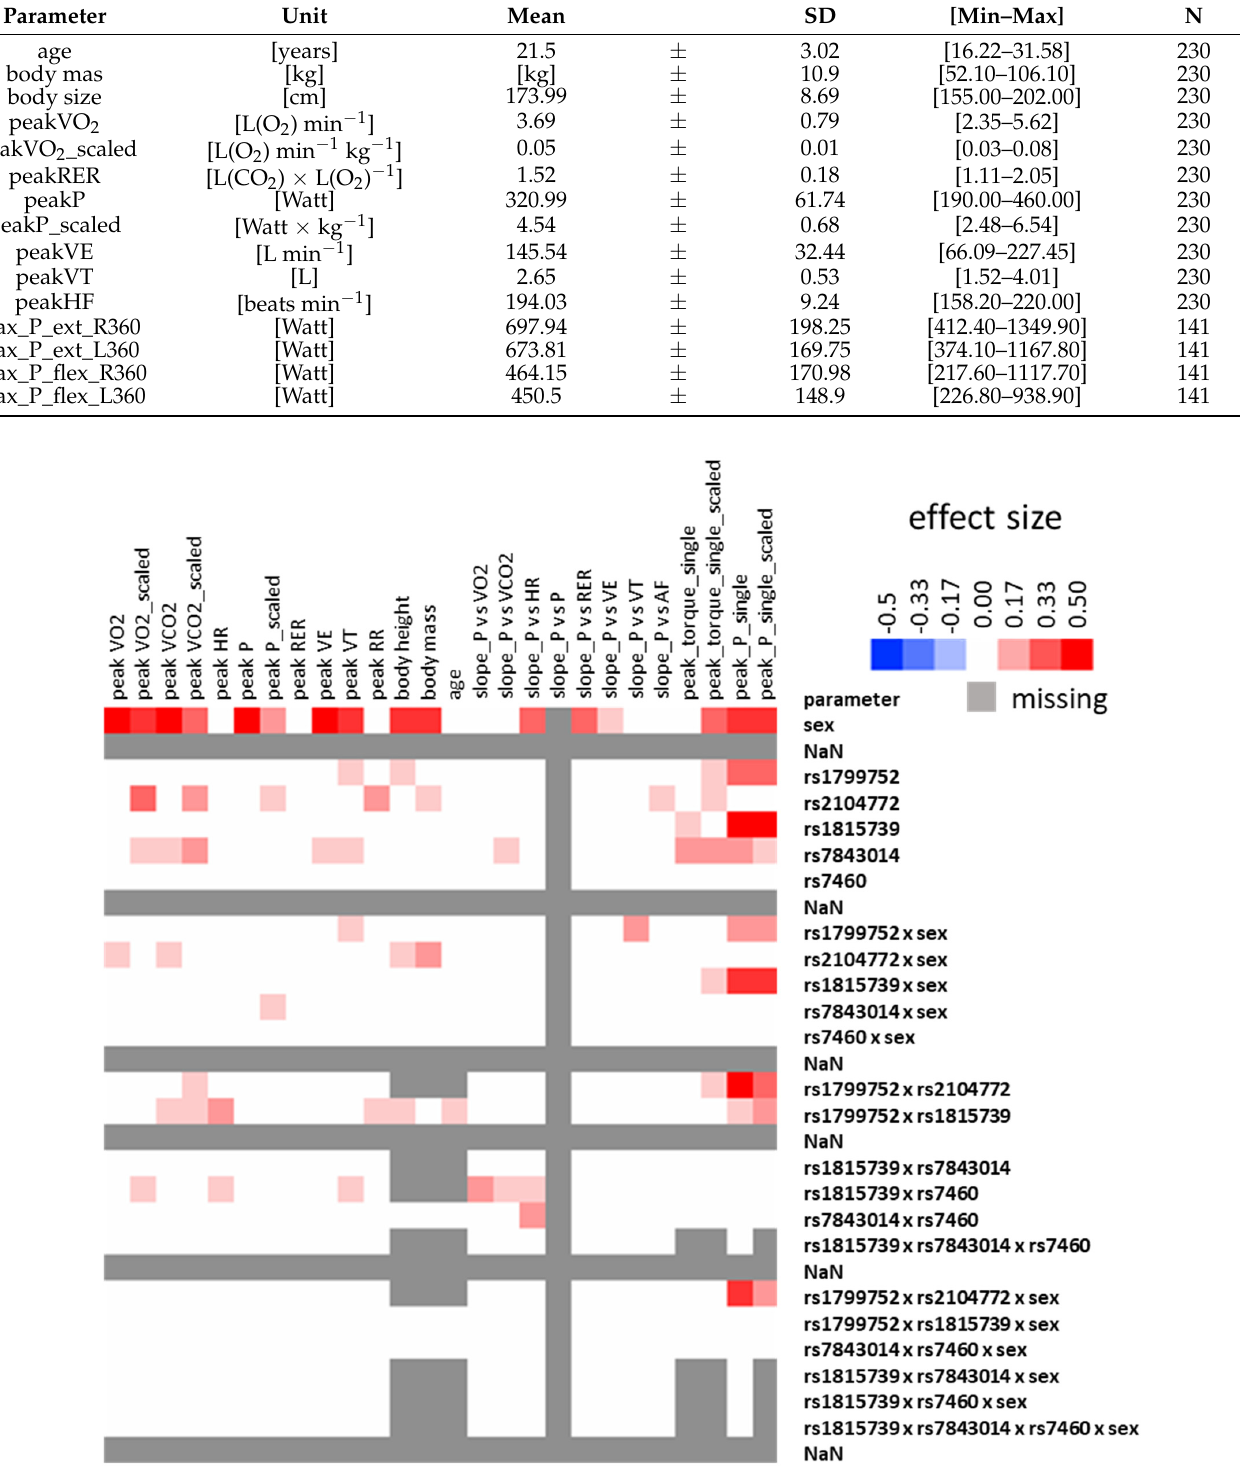
Figure 2. Heatmap of effect sizes. Coloured graph visualizing the calculated effect sizes for cardiorespiratory parameters during the CPX testing and performance values during the dynamometer test as calculated with ANOVAs for the factors genotype × sex × discipline. Effect sizes above 0.10 are coloured in red, with those below appearing in white, or if calculation was not possible in grey. Abbreviations: HR, heart rate; NaN, no values; peak P, peak power during CPX testing; peak_P_single, peak power of a single contraction; peak_torque, peak torque of a single